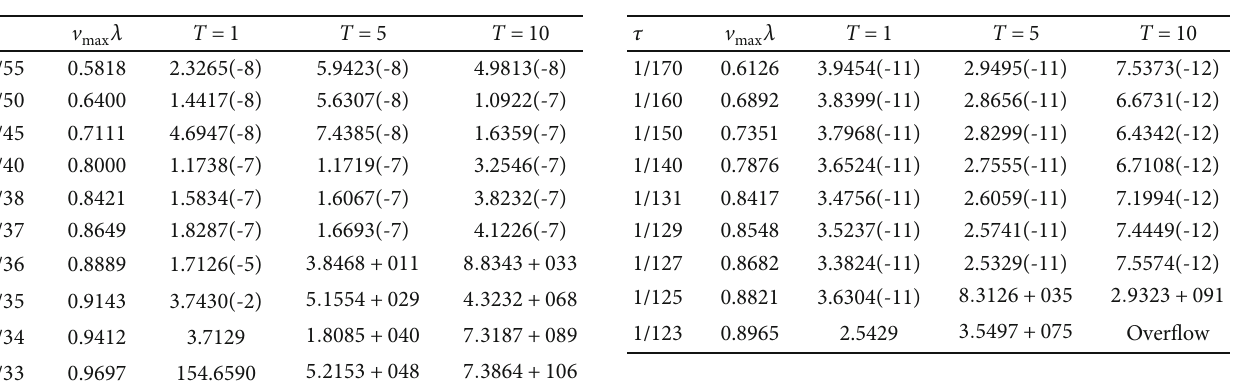
ff erent τ and T for